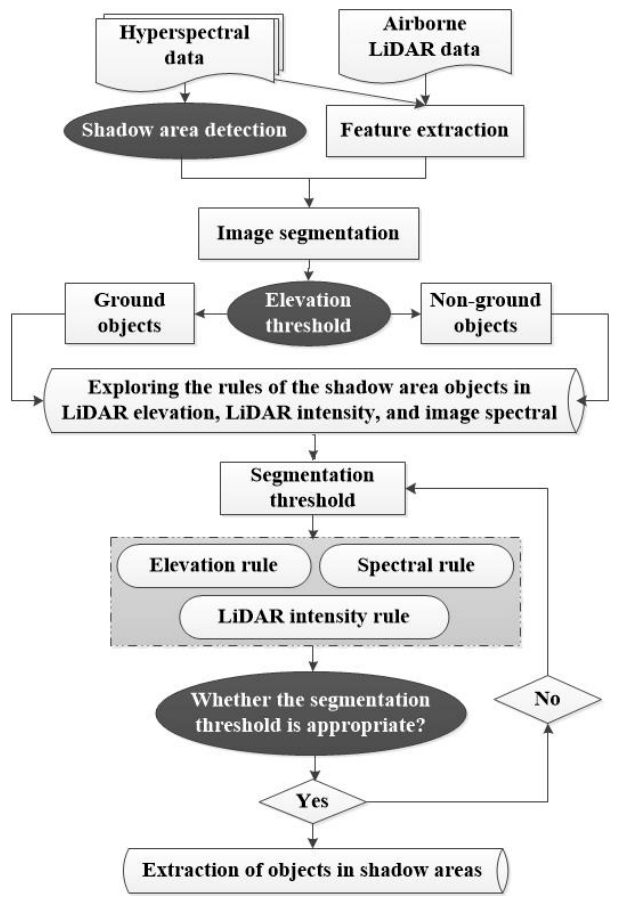
Figure 4. The flowchart of urban object extraction from shadow areas with the fusion of airborne light detection and ranging (LiDAR) and hyperspectral data.